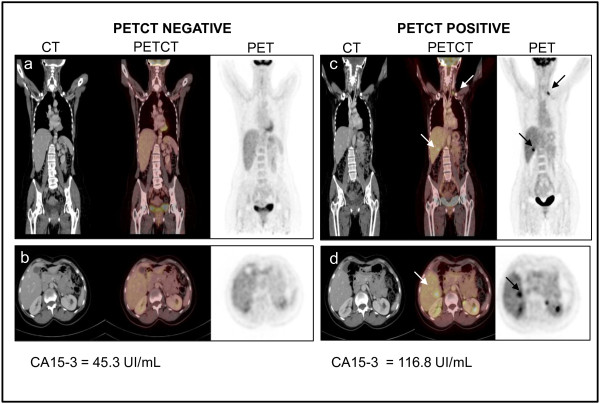
Right side: example of a patient with negative PETCT findings (a: coronal view; b: transaxial view) and CA15-3 levels of 45.3 UI/mL; left side: the same patient 6 months later with positive PETCT findings (c: coronal view; d: transaxial view) as well as CA15-3 levels of 116.8 UI/mL. Arrows indicate the metastatic sites.